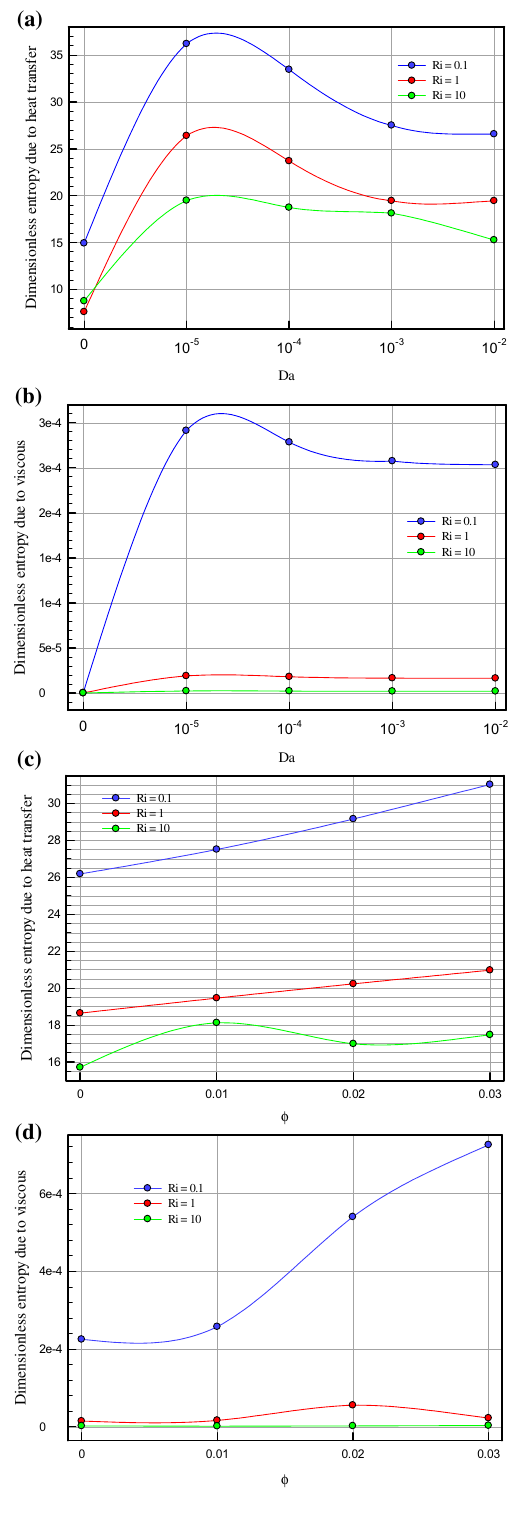
Figure 8. ( a ) Effect of different Darcy number on entropy generation for τ = 0.1, different Darcy number on entropy generation for τ = 0.1, on entropy generation for τ = 0.1, ɛ = 0.7, Da = 10 –3 . ( d ) Effect of different Darcy number on entropy generation for τ = 0.1, ɛ = 0.7, Da = 10 –3